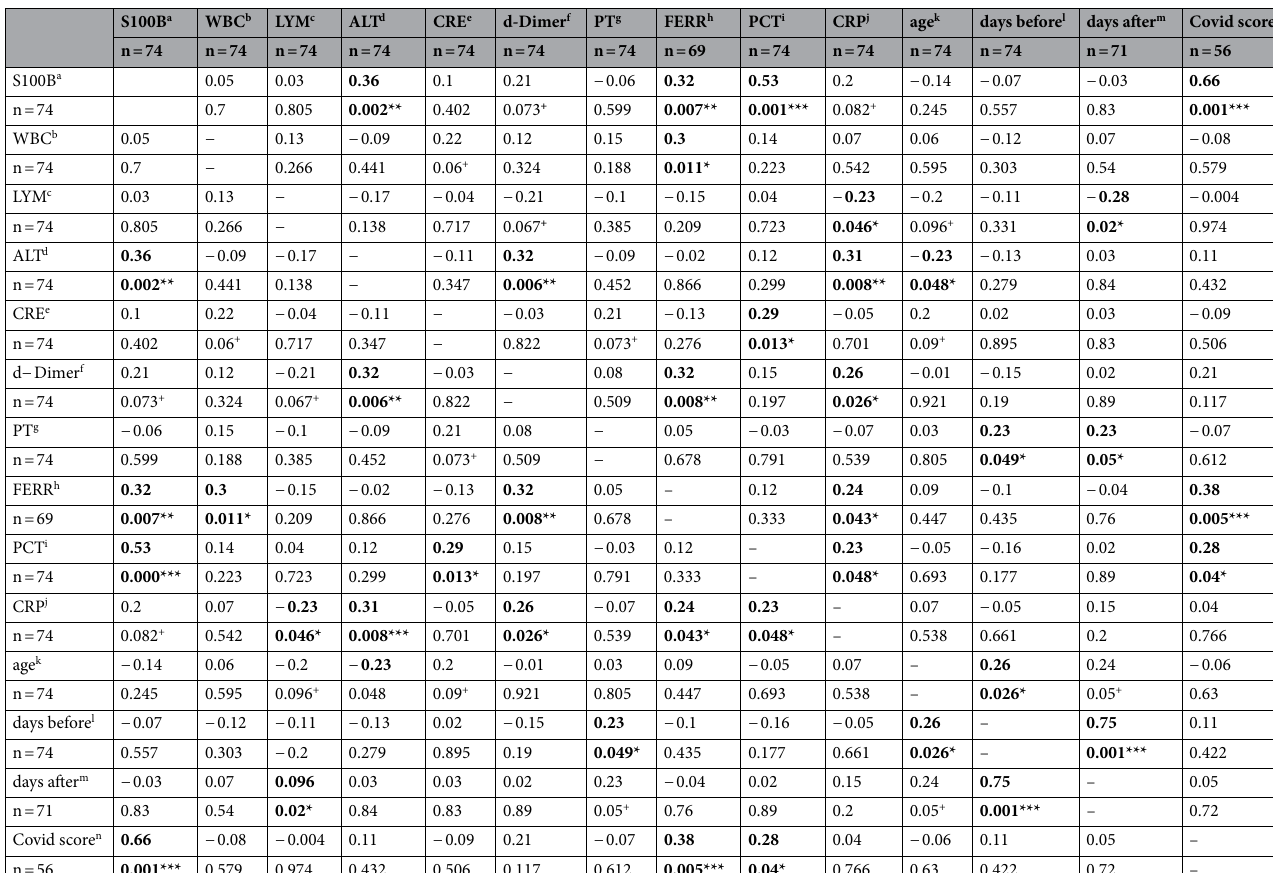
Table 2. Correlation matrix: Pearson correlation coefficients and relative p values. Statistically significant results are highlighted in bold. n number of patients. a S100B protein, ng/mL. b White Blood Cell count